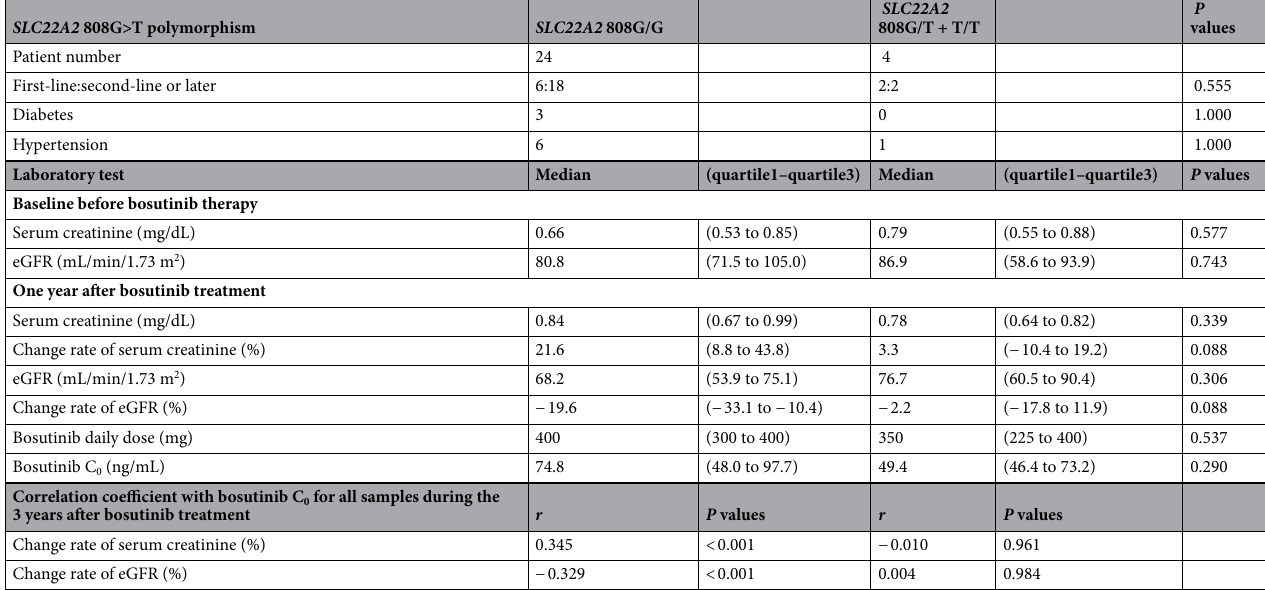
Table 3. Comparison of laboratory test data after bosutinib administration between patients with the SLC22A2 808G/G genotype and 808T allele. C 0 trough plasma